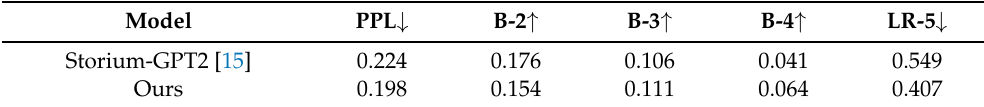
Table 2. Automatic evaluation results of story generation models.